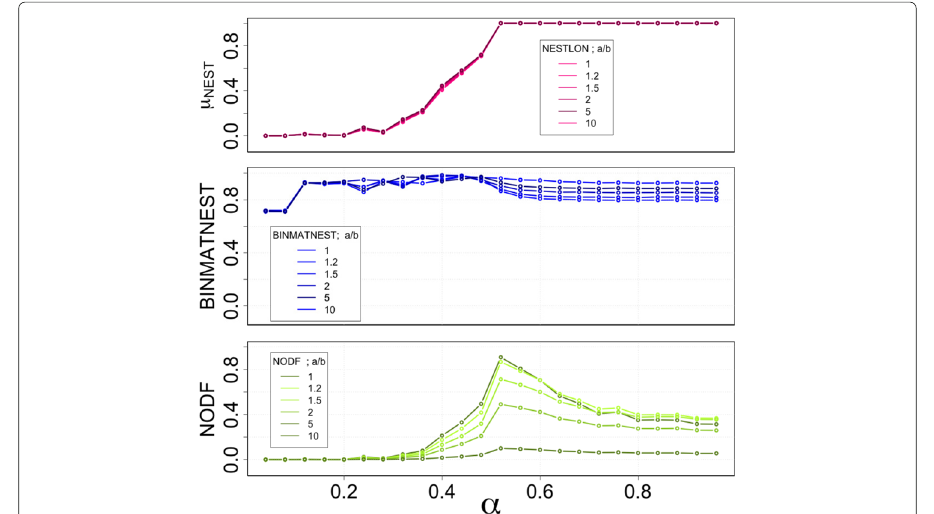
Fig. 7 Sensitivity analysis among NESTLON, BINMATNEST, and NODF on a benchmark graph with added noise ρ rew = 0.5. The sensitivity in nestedness under the variation of the matrix shape (i.e. n a / n b ) is much higher for the method NODF than for the two other methods BINMATNEST and NESTLON. We perform the computation on a bipartite graph of set size n b =